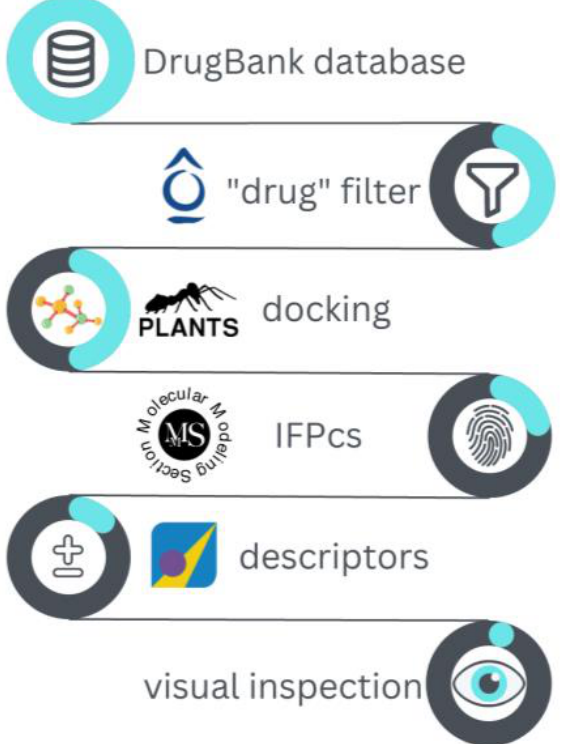
Figure 4. Schematic representation of the workflow for the virtual screening performed on the DrugBank database against the monkeypox virus I7L protease catalytic site.